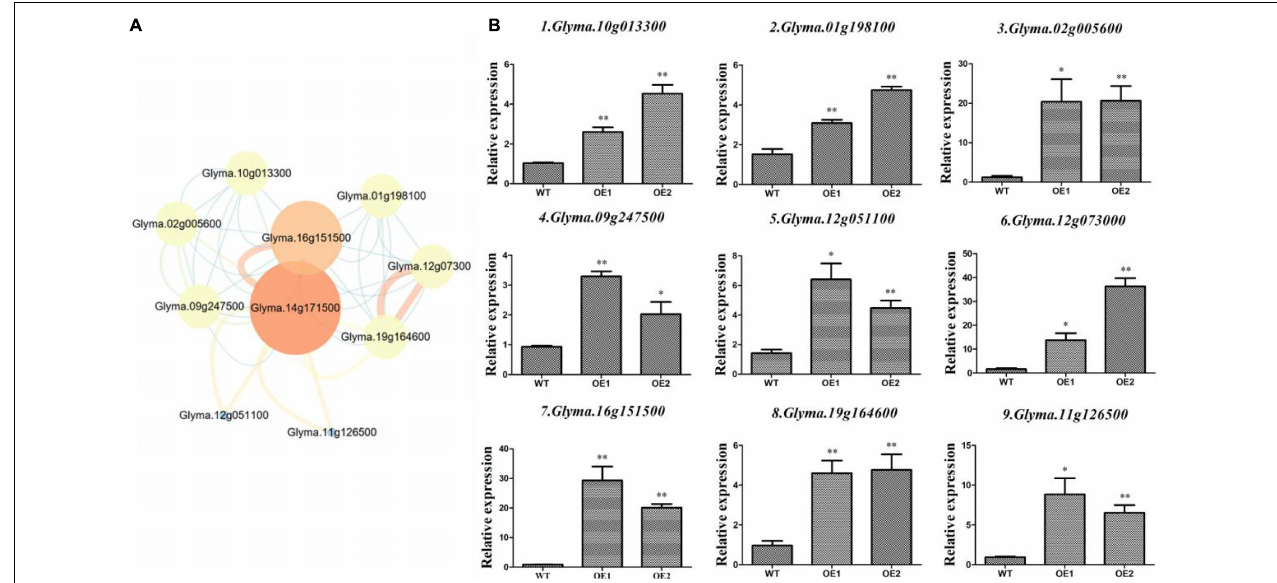
FIGURE 7 | Expression of interacting genes in the regulatory network of GmAP2/ERF144 . (A) STRING-predicted regulatory network of genes interacting with GmAP2/ERF144 in soybean. (B) Expression profiles of nine genes (of 10) that interacted with GmAP2/ERF144 in wild-type (WT) and overexpressing (OE) lines of soybean. Protein–protein interaction network of GmAP2/ERF144 was detected in silico using the STRING database (https://string-db.org/). Values are the mean ± SE, n = 3. ∗ p < 0.05; ∗∗ p < 0.01 (Student’s t